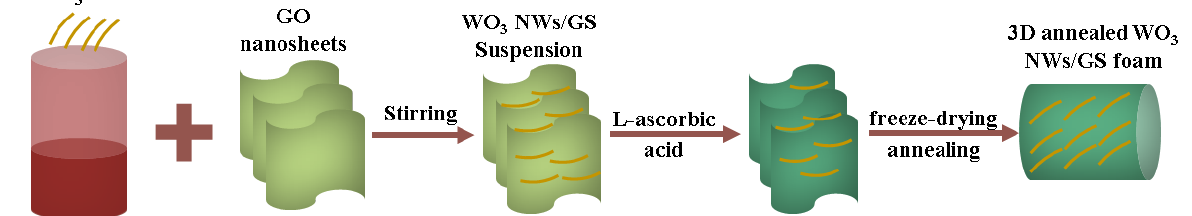
Figure 8. Graphical representation of 3D annealed WO 3 NWs-GS foam preparation. Adapted from Ref. [77]. Copyright © 2017, Royal Society of Chemistry. Ref. [77]. Copyright © 2017, Royal Society of